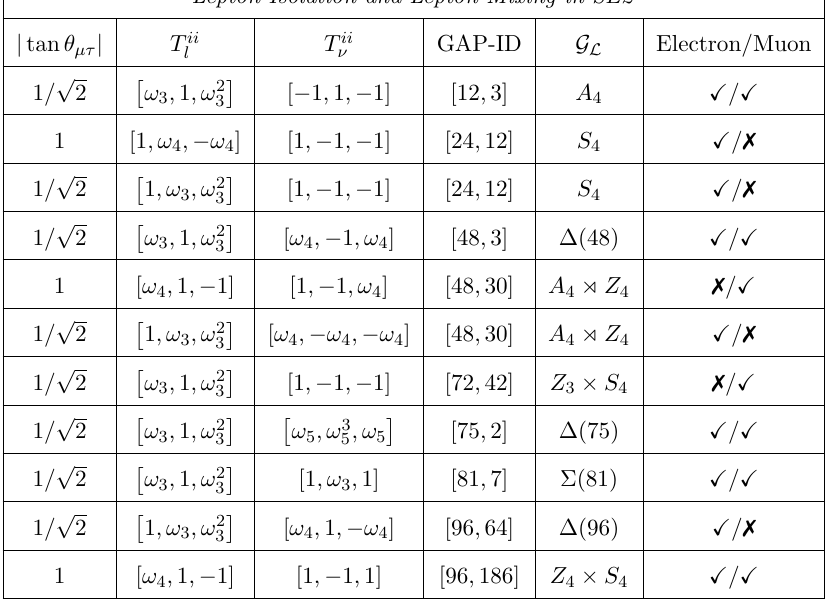
Table 9 . The same as in table 8 but for G Q (cid:2)G L group structures. f c; d g = f N= 2 ; 3 g for D and f c; d g = f N; 1 g for D N =14 . Again, M 2 f 1 : : : 5 g and the phase alignments shown are for D 14 | send T ii ! [1 ; -1 ; -1] for D 28 ; 30 . u Lepton Isolation and Lepton Mixing in SE2